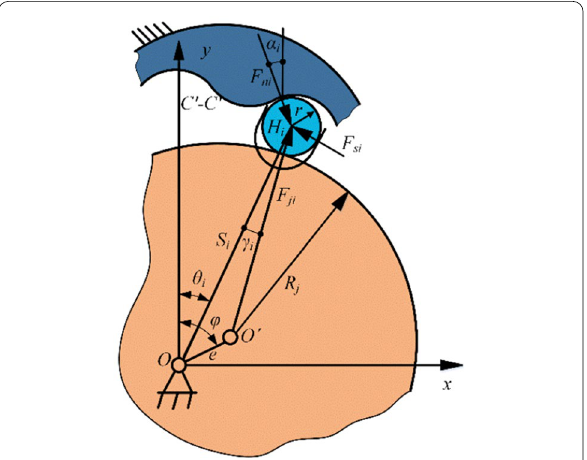
Figure 3 Force analysis of cam-guild link-roller combinatorial linkage mechanical